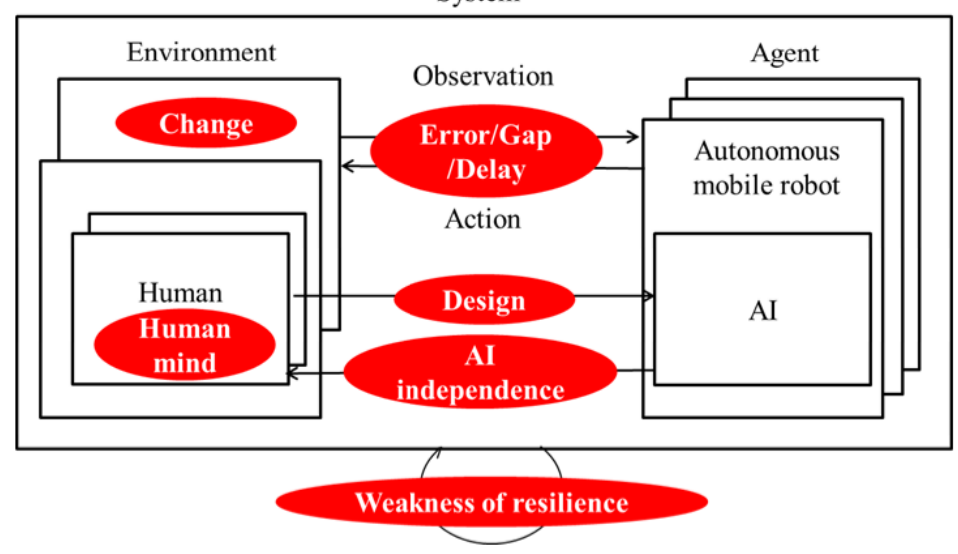
Figure 3. Characteristic risks to deep reinforcement learning.